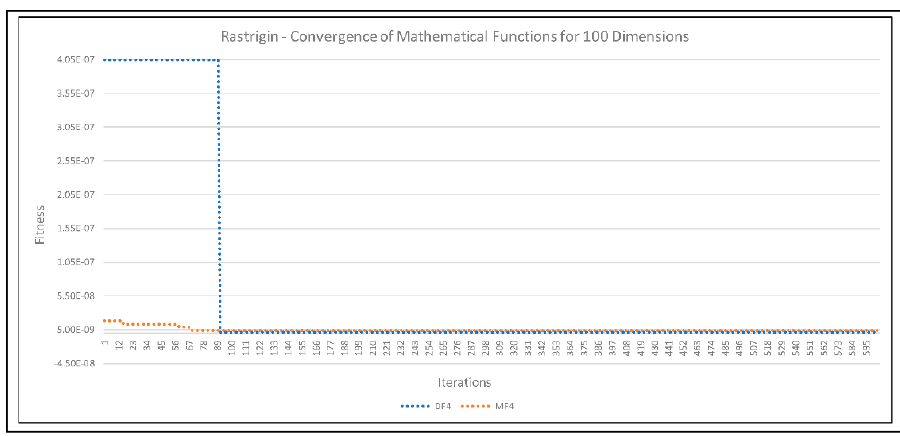
Figure 7. Ackley-Convergence of the DMOA and MTOA algorithms for 50 dimensions.